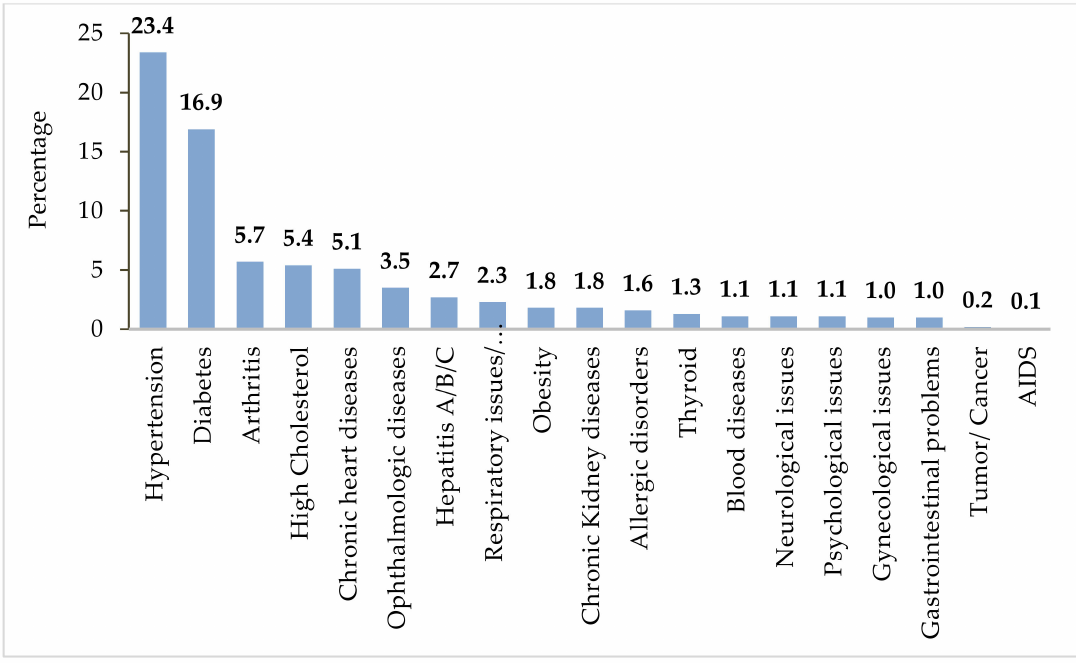
Figure 2. Percentage of history of different chronic conditions ( n = 1325).